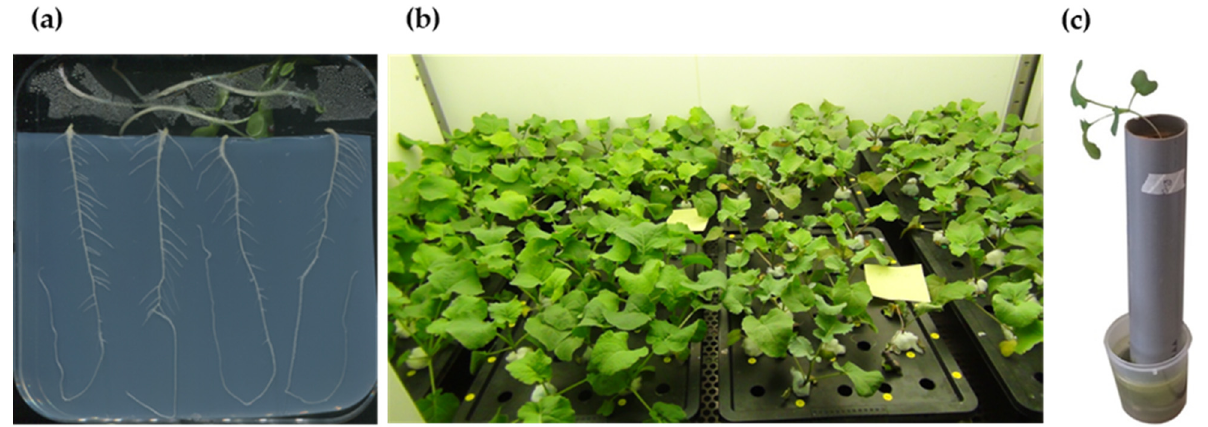
Figure 1. Culture systems used to grow oilseed rape cultivars. ( a ) Vertically placed agar plates (size: 12 cm × 12 cm); ( b ) Hydroponic containers (capacity: 8 L); ( c ) Column filled with soil (d: 5 cm, h: 30 cm).